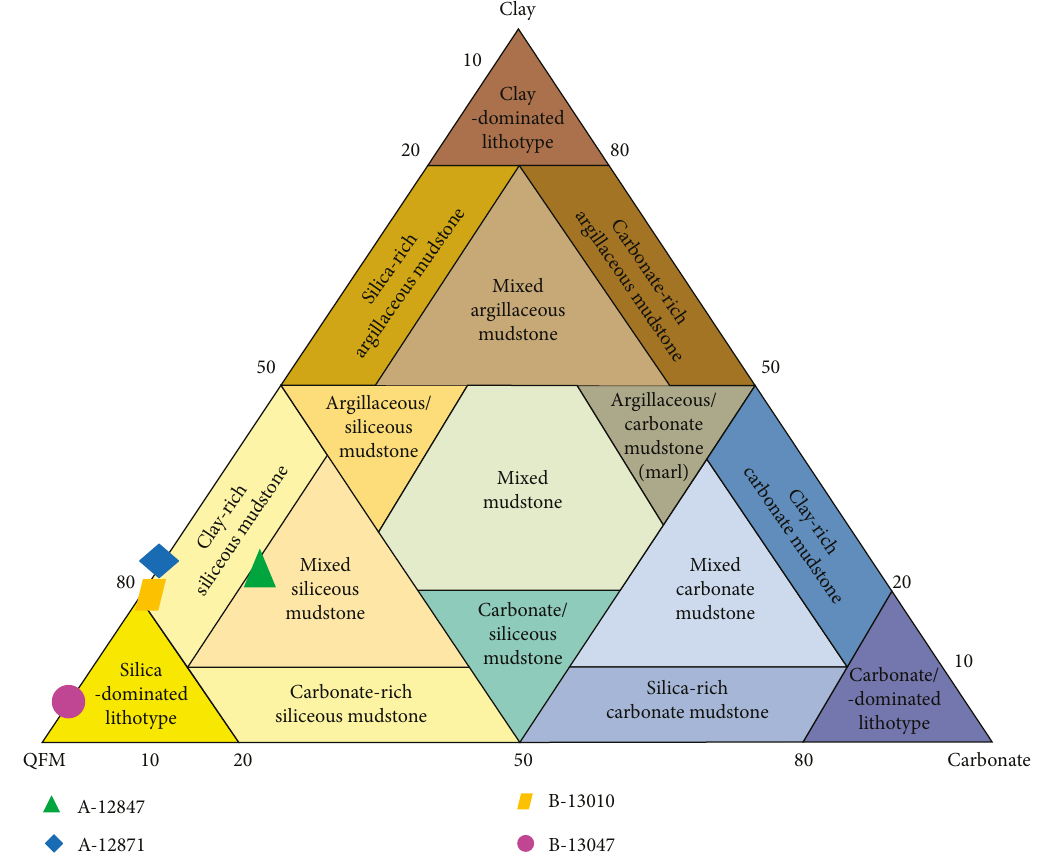
Figure 5: A ternary diagram for sCore lithofacies classi fi cation scheme for organic mudstones proposed by Gamero-Diaz et al.